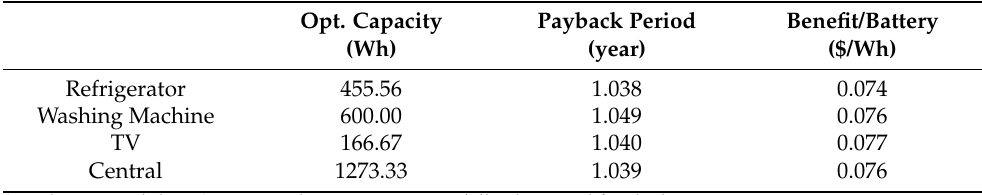
Table 7. Economic benefit and payback period of distributed and central